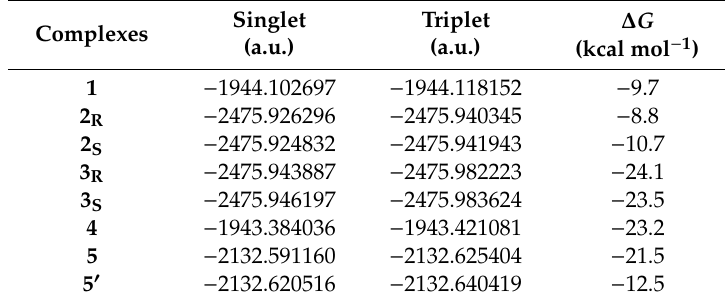
Table 2. Absolute and relative free energies of singlet and triplet states of the intermediates in the ATH of pyruvic acid catalyzed by 1 . ∆ G Singlet Triplet Complexes (a.u.) (a.u.) (kcal mol − 1 ) 1 − 1944.102697 − 1944.118152 −